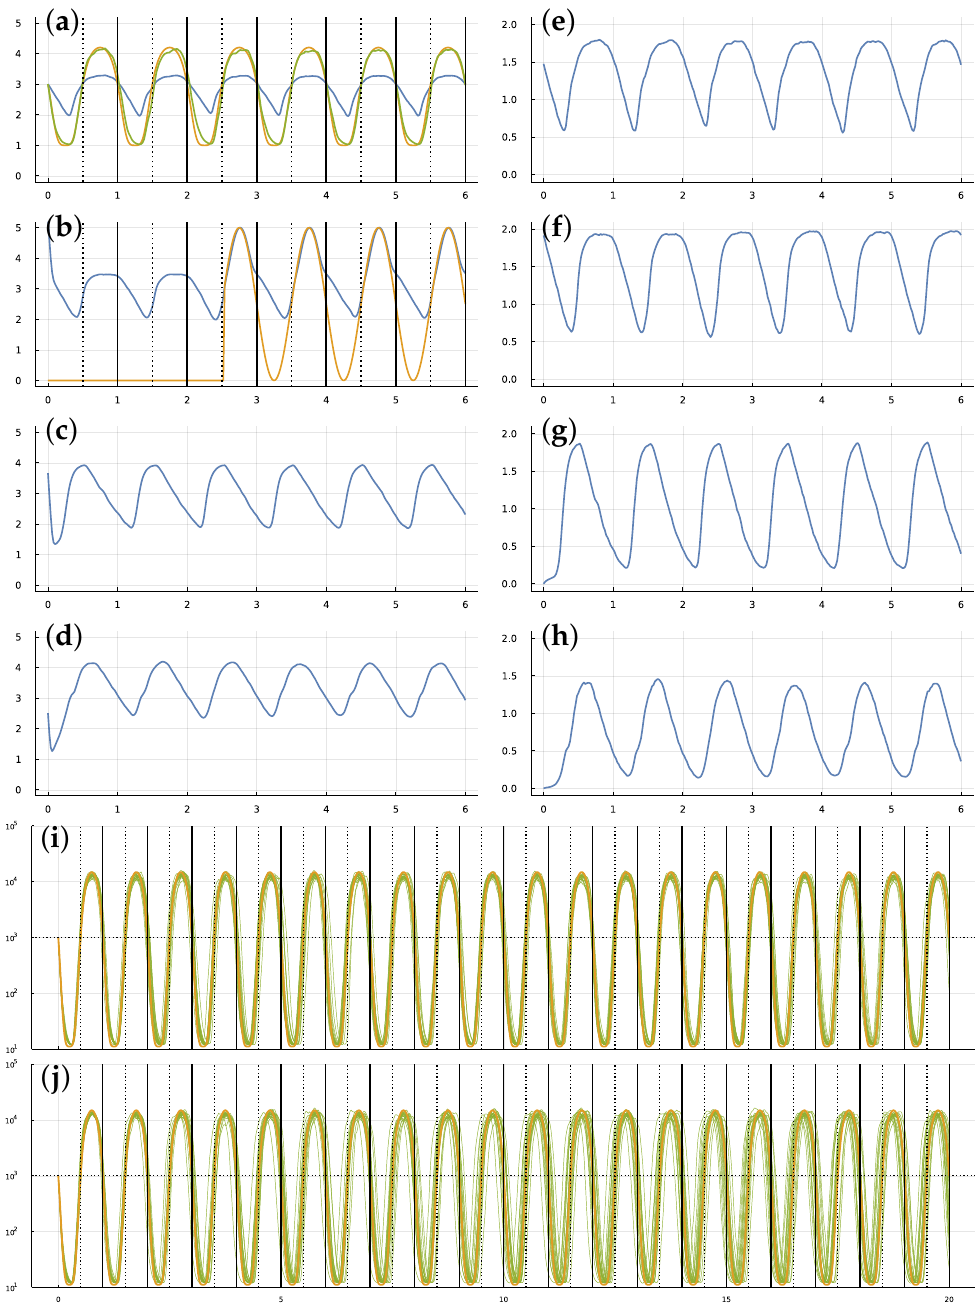
Figure 1. Circadian dynamics with stochastic fluctuations and random daylight signal.